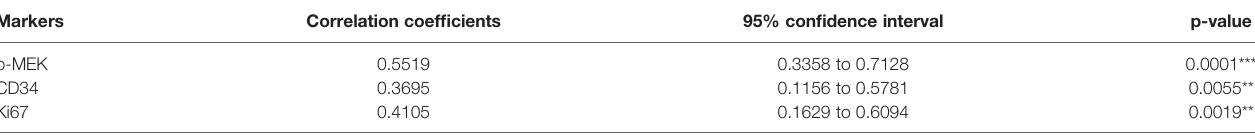
TABLE 1 | Pathological parameter with p-ERK expression. Markers